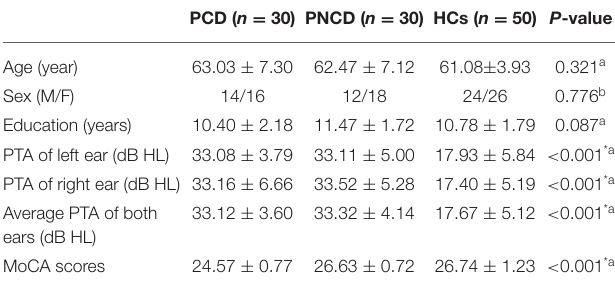
TABLE 1 | Demographics of the presbycusis patients and